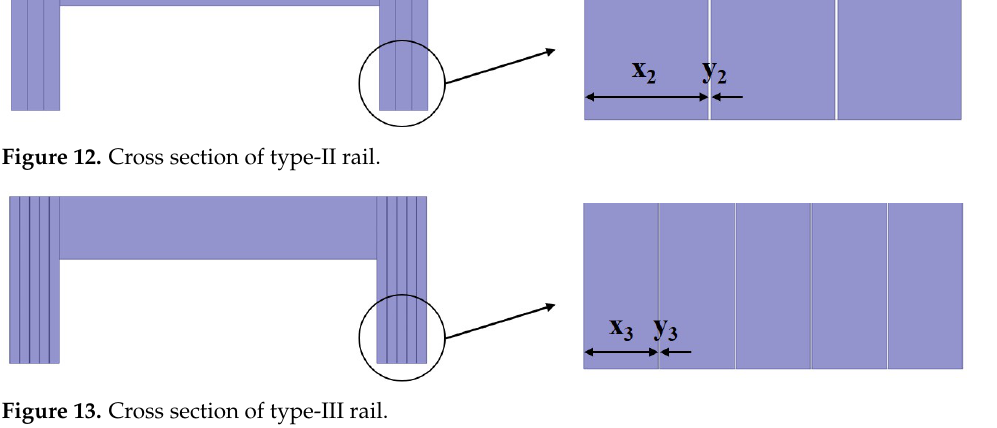
Figure 13. Cross section of type-III rail.